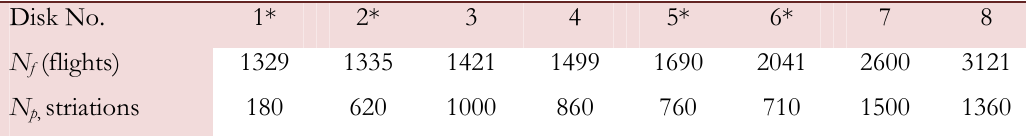
of fatigue striations for the cracks detected in service p